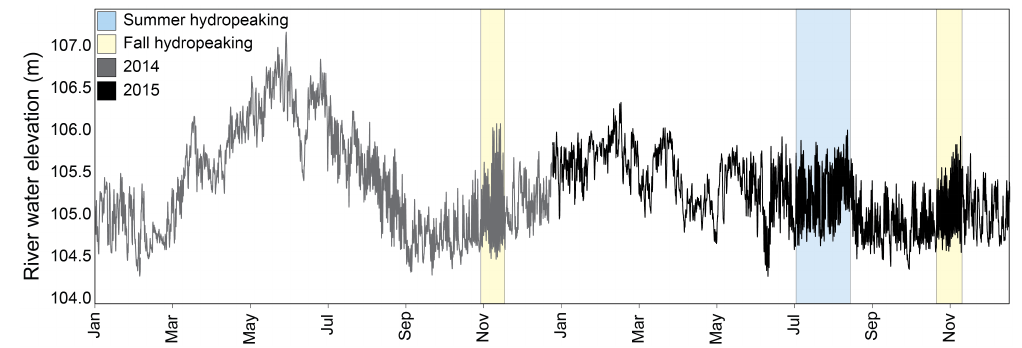
Figure 5. River water elevation near the study site, 2014 through 2015. Note that melting snowpack caused an increase in water elevation during the spring of 2014. In 2015, the lack of spring water elevation rise was due to very little snowpack in the winter, which then led to increased hydropeaking in the summer of 2015 that is not seen in 2014 and is typically only seen in late fall.